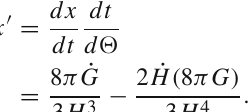
, α 2 < 3 taking C o = 8 π G = 3